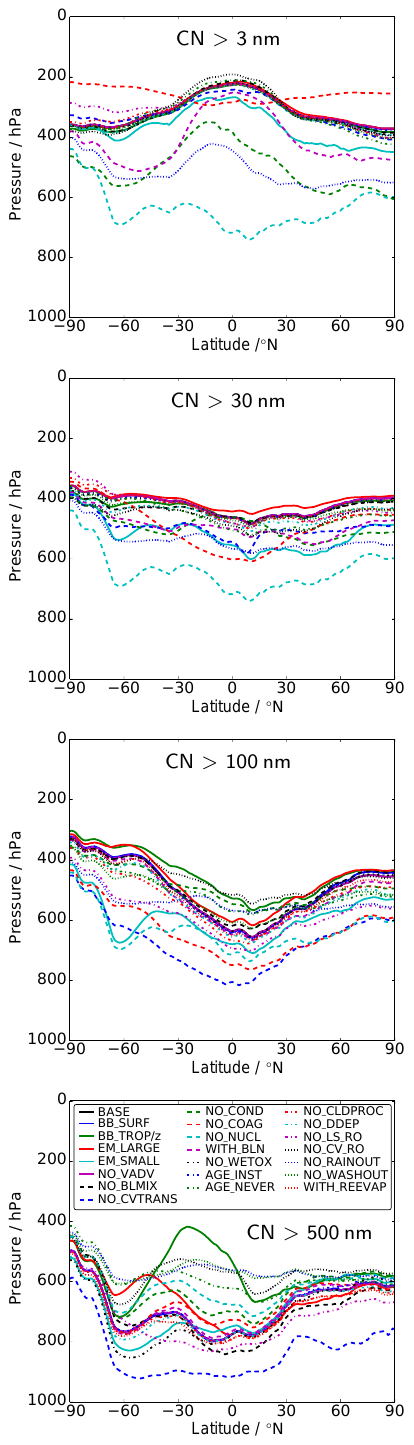
Figure 5. Annual- and zonal-mean number-weighted mean pressure level (vertical centre of number in pressure coordinates) of conden- sation nuclei (CN) above 3, 30, 100 and 500nm dry diameter from the HadGEM3–UKCA sensitivity-test simulations.